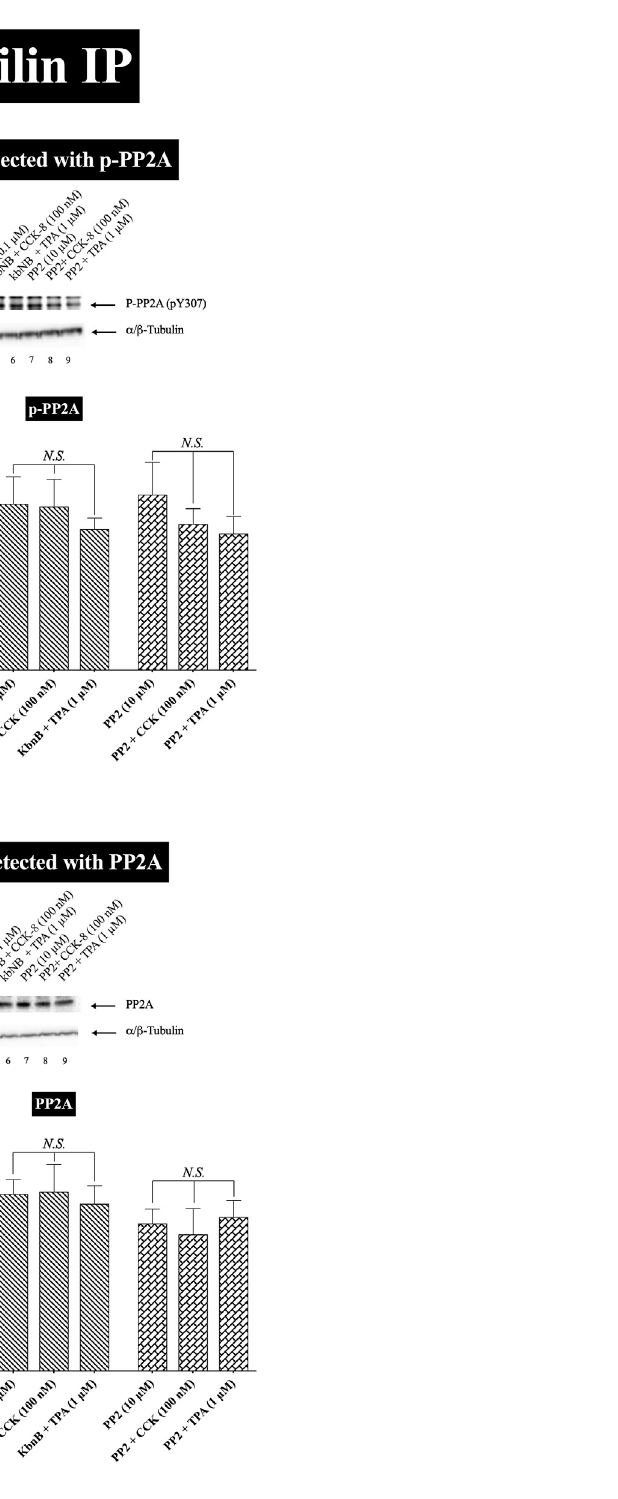
FIGURE 8 Effect of a PKD inhibitor, kbNB, or a Src inhibitor, PP2, on the ability of CCK-8 (100 nM) and TPA (1 µM) to stimulate the association of co fi lin with either phospho-PP2A (A) or total PP2A (B) . Isolated pancreatic acini were incubated in the absence or presence of kbNB (0.1 µM) or PP2 (10 µM) for 3 h and then incubated with no addition (control), CCK-8 (100 nM, 3 min) or TPA (1 μ M, 5 min), and then lysed. Equal amounts of protein were co- immunoprecipitatedwithananti-co fi lin(SantaCruz, SC-376476) andthensubjectedtoWesternblots usinganti-pY307PP2Aandanti-PP2A.Bands were visualized using chemiluminescence and quanti fi ed by densitometry. Top : Results of a representative blot of four independent experiments are shown. Bottom : Means ± S.E. of at least 4 independent experiments. Results are expressed as % of basal stimulation of the control group. N.S. , No signi fi